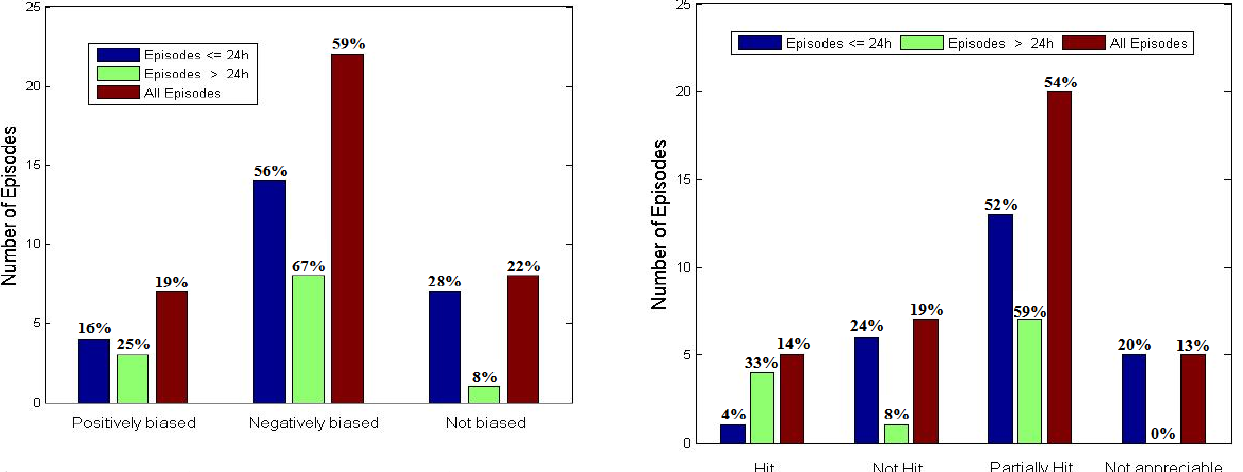
Fig. 5. Bias tendency for MM5’s QPFs against rainfall observations for all warning episodes during 2008. Figure 5. Bias tendency for MM5‟s QPF against rainfall observations for all warning 3 episodes during 2008. 4